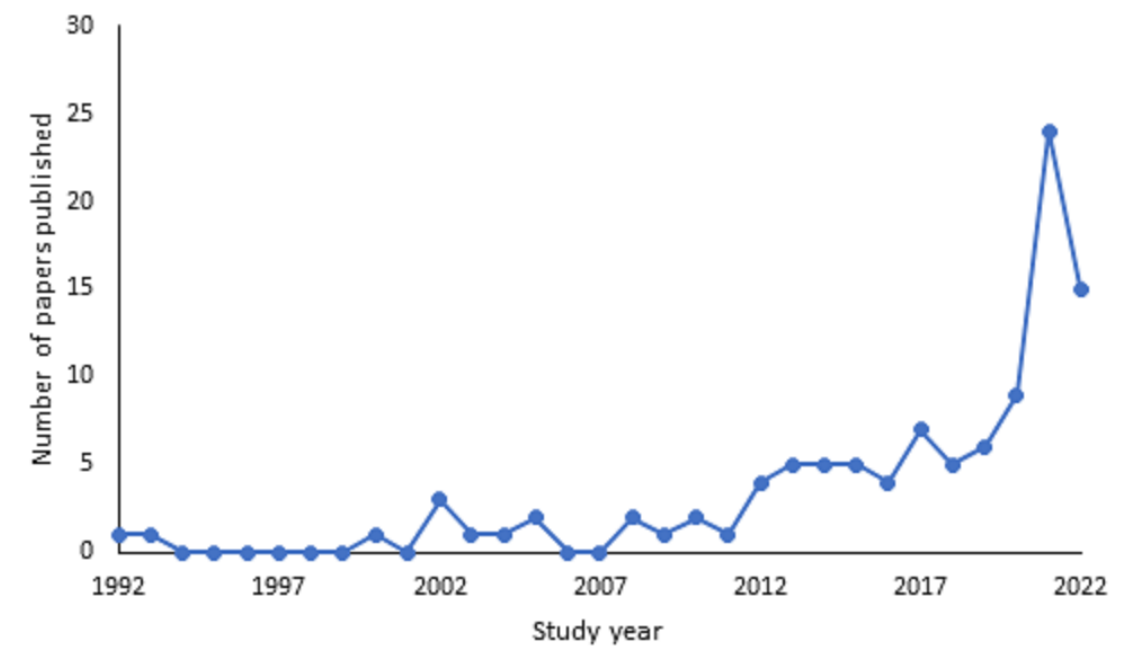
Figure 2. An overview of the number of papers produced per study year from 1992 to 2022.